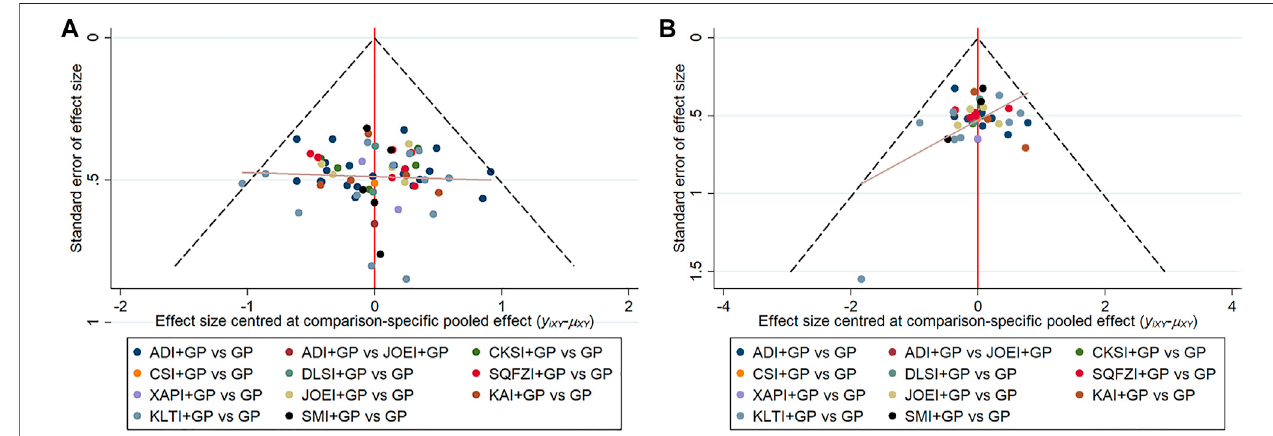
FIGURE 7 | Comparison-adjusted funnel plot for outcomes. (A) clinical effectiveness rate; (B) performance status. Note: ADI, Aidi injection; CKSI, Compound Kushen injection; DLSI, Delisheng injection; GP, Gemcitabine plus Cisplatin; JOEI, Javanica oil emulsion injection; KAI, Kangai injection; KLTI, Kanglaite injection; SMI, Shenmai injection; SQFZI, Shenqifuzheng injection; and XAPI, Xiaoaiping